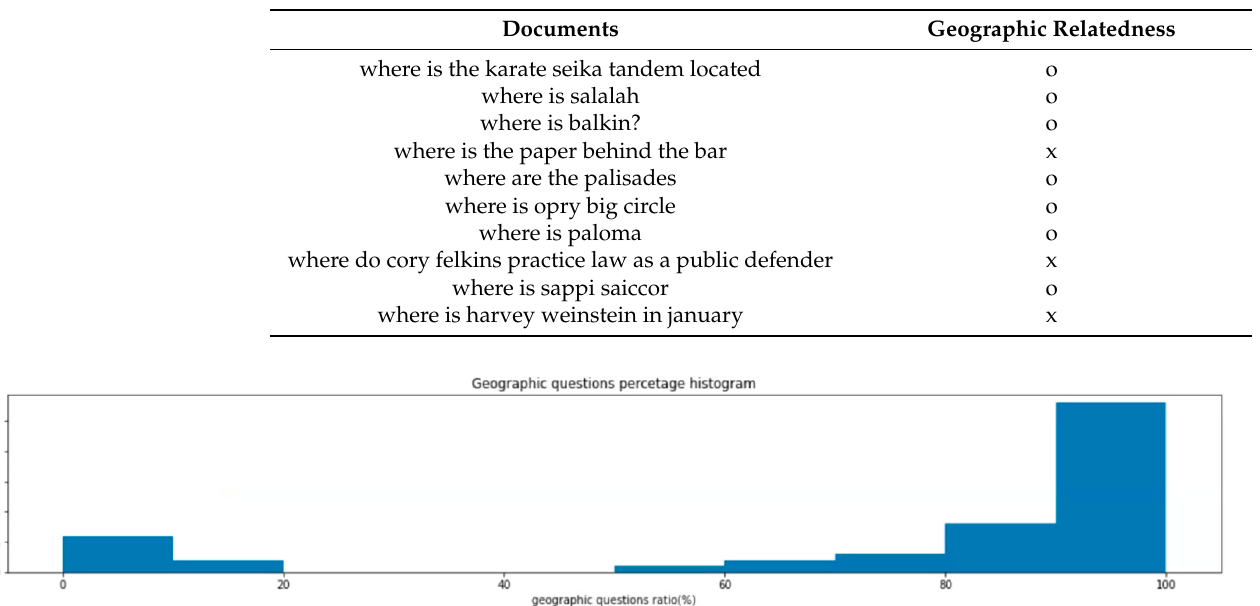
Table 13. Manual annotation examples for topic 2 regarding geographic relatedness. For each document, we manually annotated that the documents are related to the geographic domain or not.